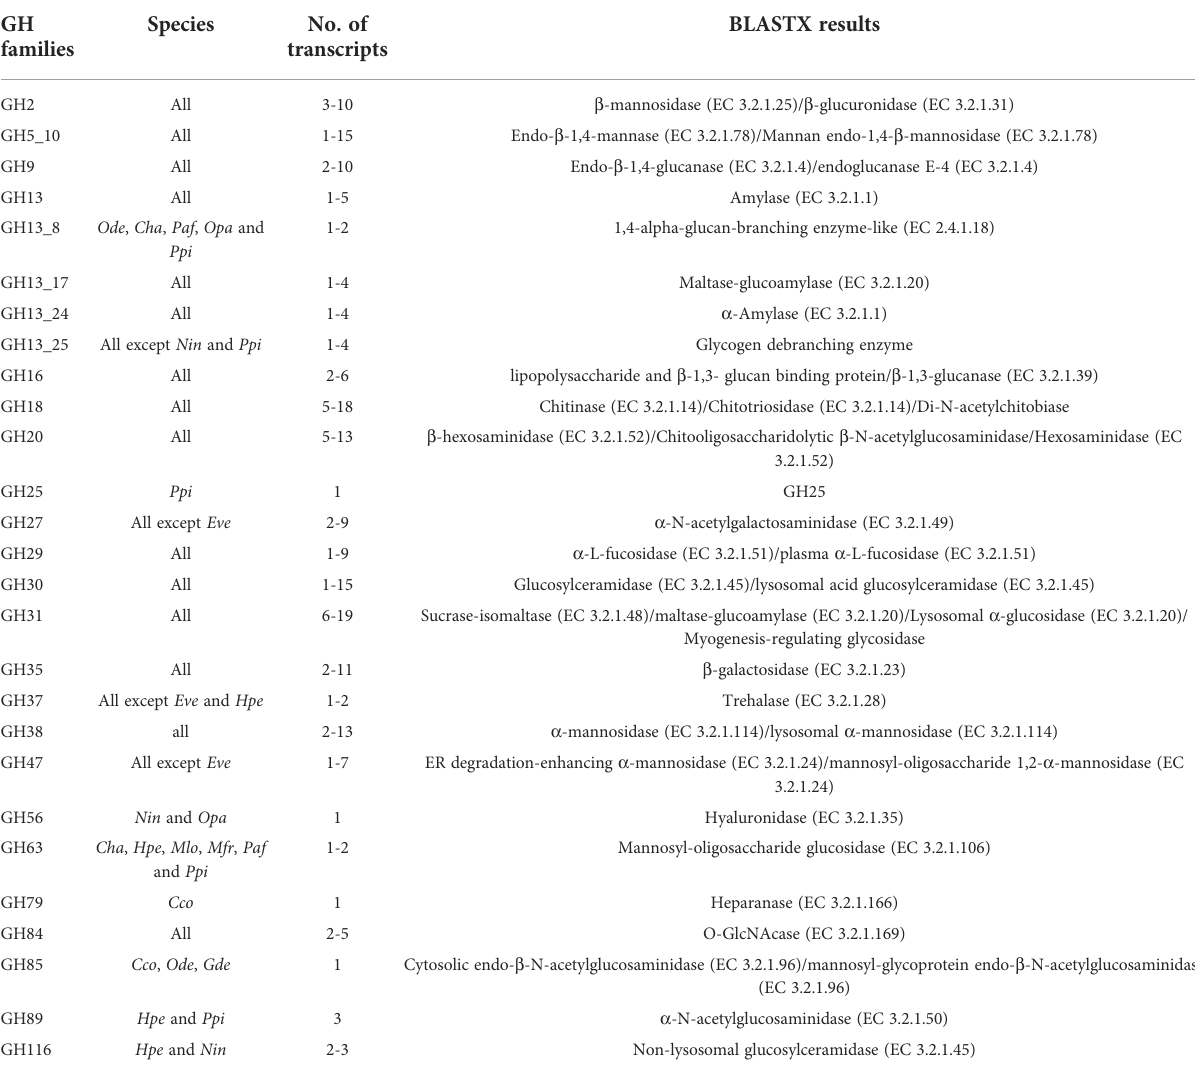
TABLE 5 GHs identi fi ed in transcriptomic analysis. GH Species No. of families